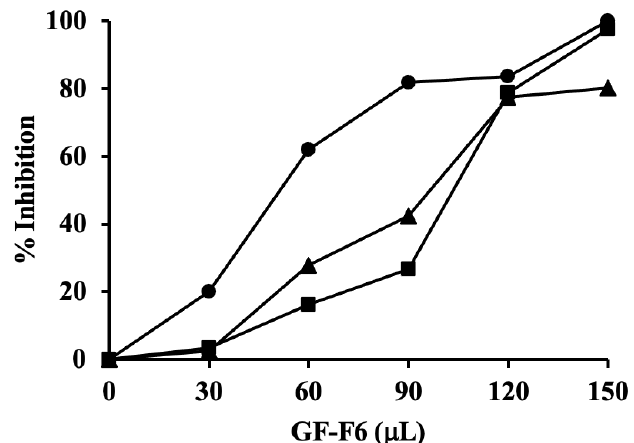
Figure 5. Anti-bacterial activity of the active fraction from gel filtration (GF-F6). The percent inhi- bition was calculated by comparing with A 600 of the control without antibiotic after the cultures reached stationary phase (8 h for E. coli (triangles), 13 h for B. subtilis (circles), and 20 h for A. acti- nomycetemcomitans (squares)).